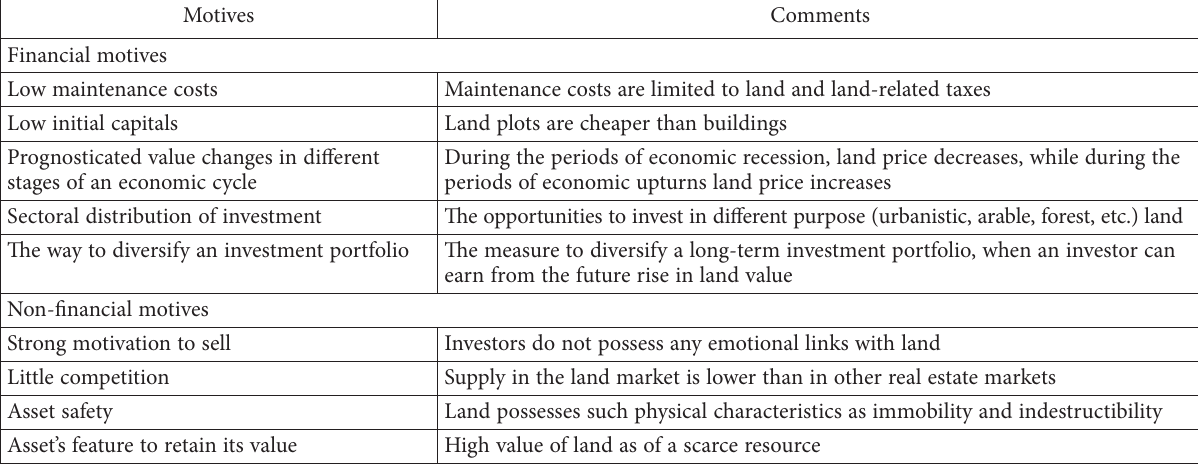
Table 1. Land investment